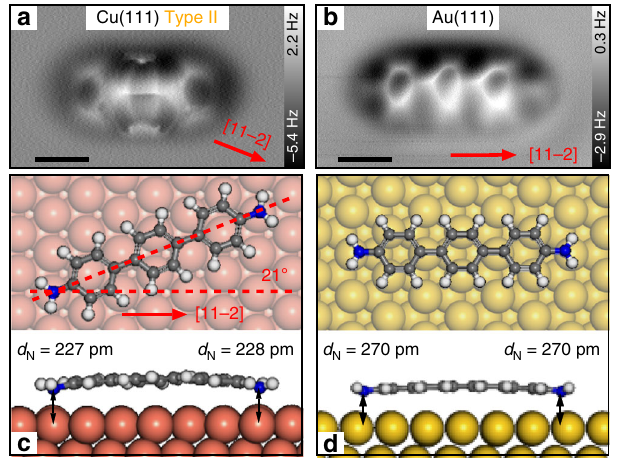
Fig. 4 Adsorption structures of DATP type II on Cu(111) and Au(111). a AFM image of DATP type II on Cu(111). b AFM image of DATP on Au(111). c , d DFT simulations of corresponding adsorption structures on Cu(111) and Au (111), respectively. Scale bar: 0.5 nm